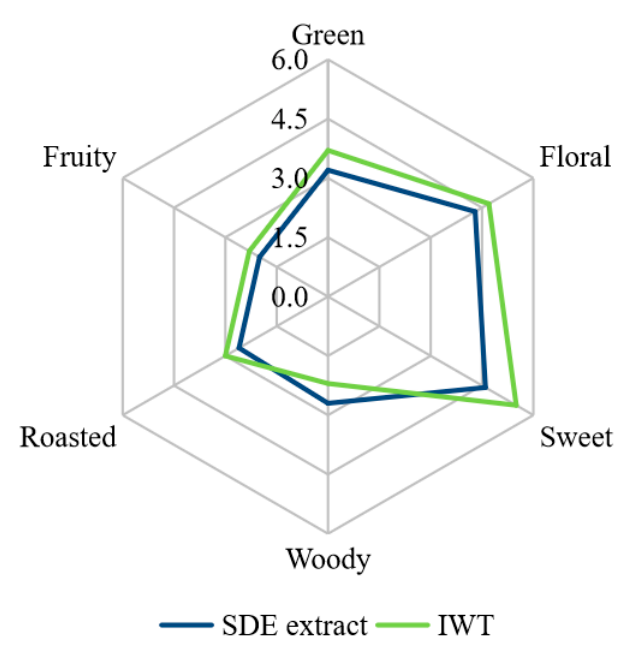
Figure 1. Sensory evaluation of simultaneous distillation–extraction (SDE) extracts and instant white tea (IWT) samples. SDE extracts and IWT samples showed significant difference ( p < 0.05) in the sweet note.